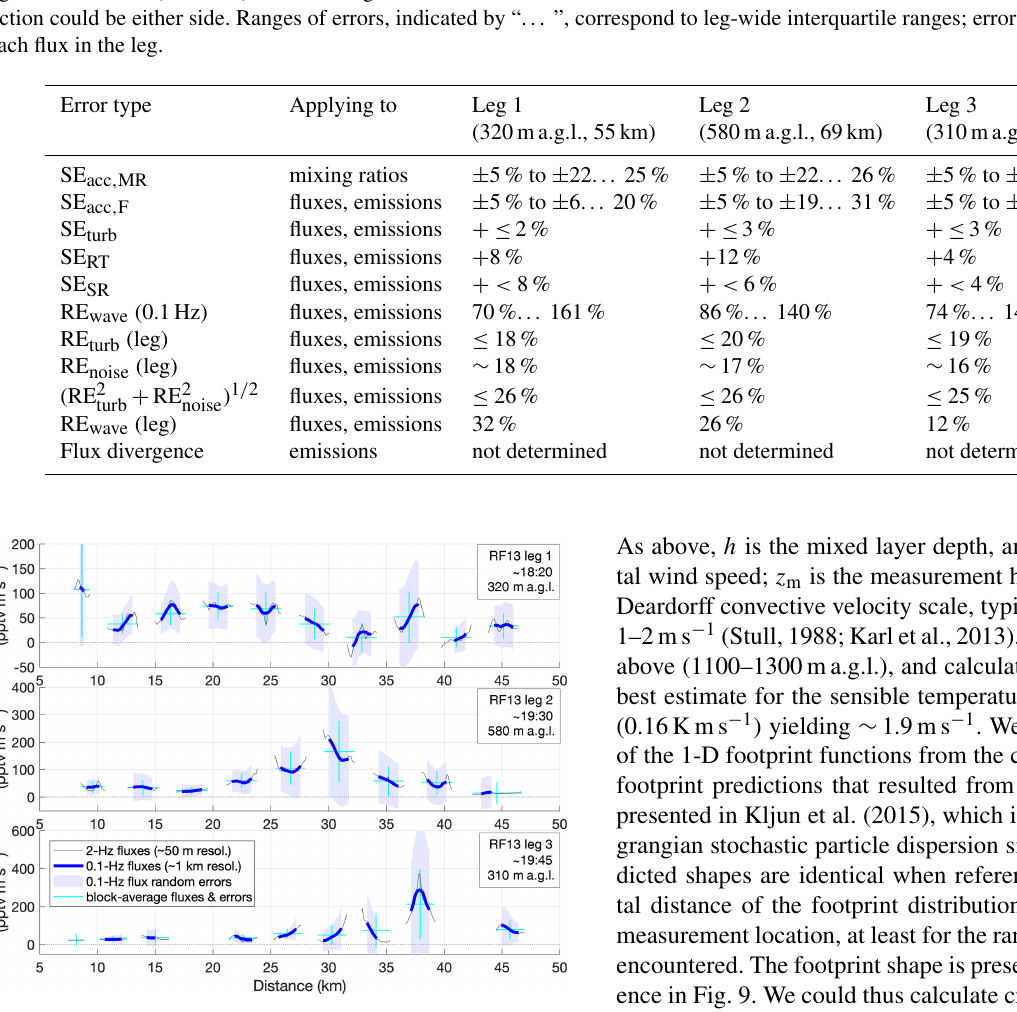
Figure 8. Total random flux errors along the F CWT time series for the three case-study legs (Figs. 6, 7), estimated empirically us- ing wavelet coefficients (RE wave ). Quality-controlled F CWT values (red in Figs. 6, 7) are shown (thin gray lines), along with moving averages to 0.1Hz, corresponding to spatial scales of ∼ 1km (thick blue lines). Shadings represent RE wave values ( ± 1 σ ) for those aver- ages. Horizontal cyan bars mark the width of blocks of continuous F CWT ( ∼ 2.5km) and their block-wide averages; vertical cyan bars denote the RE wave values for these